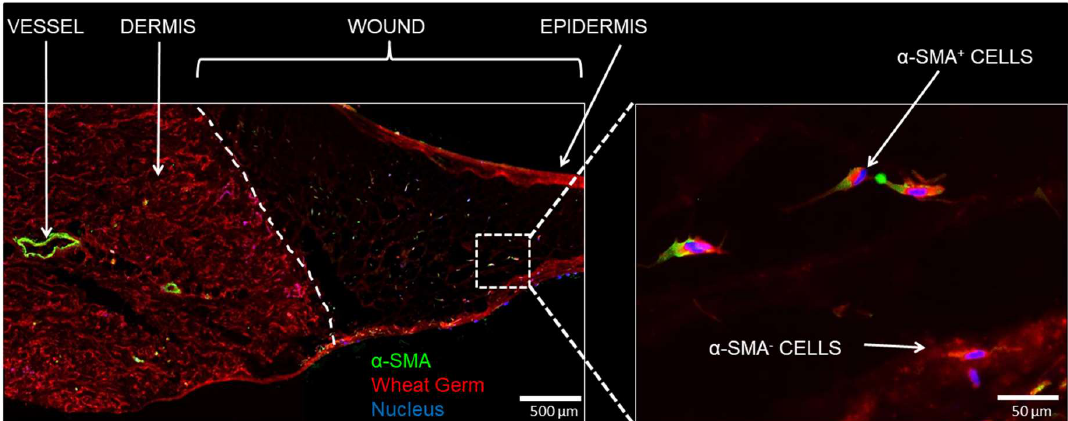
Figure 7. Immunofluorescence of cellular infiltration. ( Left ) day 14 sections treated with PEG-PFP were stained with α-smooth muscle actin (α-SMA, green), a blood vessel and mesenchymal stem cell/myofibroblast marker, and counterstained with WG (red). The white dotted line represents the boundary between normal dermis and the wound treated with PEG-PFP. ( Right ) Enlarged view of white boxed region that shows cells from the normal tissue have infiltrated and proliferated into the hydrogel. Both α-SMA positive and negative stained cells were observed.